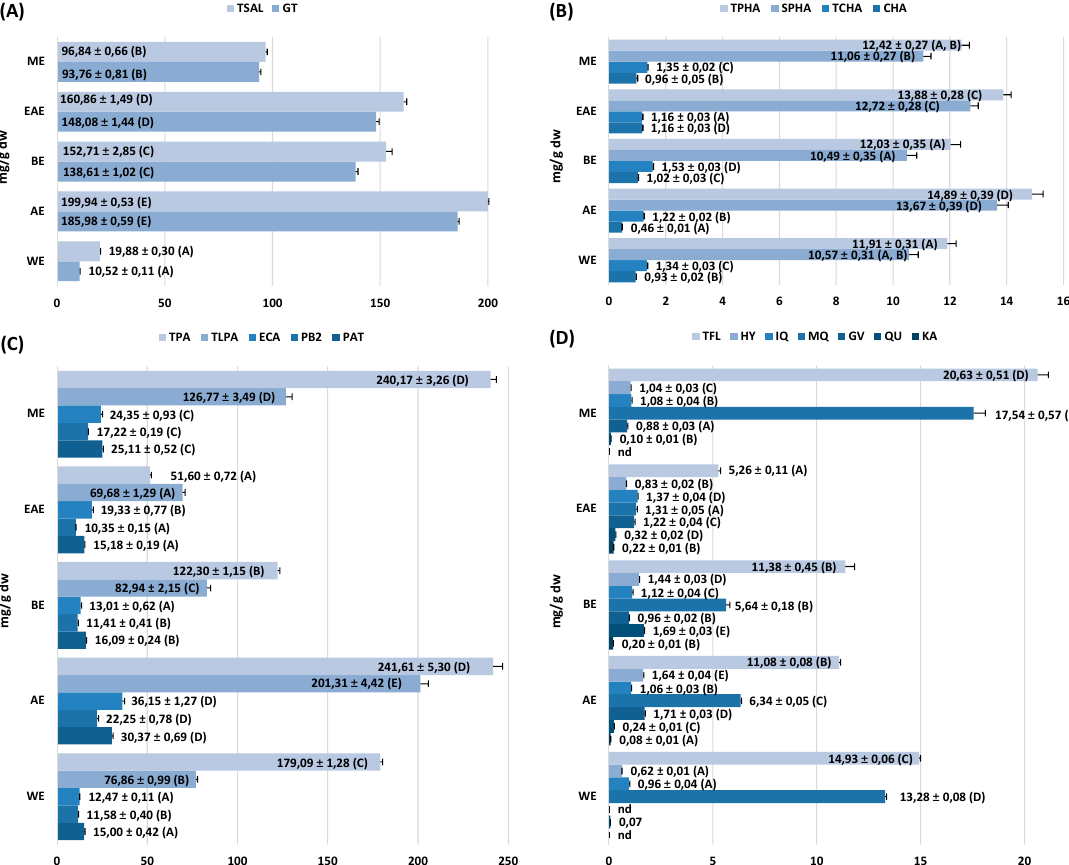
Figure 3. The quantitative data of individual compounds and groups of polyphenols in the stem dry extracts of G. procumbens : ( A ) salicylates; ( B ) phenolic acids; ( C ) flavan-3-ols and procyanidins; and ( D ) flavonoids. All data expressed as means ± SD (mg/g dw; n = 3 × 3 × 1) calculated per dw of the extracts. For each parameter, different superscripts (A–E) indicate significant differences ( p < 0.05). Additional abbreviations: SPHA, total content of simple hydroxybenzoic and hydroxycinnamic acids; TCHA, total content of chlorogenic acid isomers; CHA, 5- O -caffeoylquinic acid (chlorogenic acid); HY, hyperoside; IQ, isoquercitrin; GV, guaijaverin; KA, kaempferol; nd—not detected.